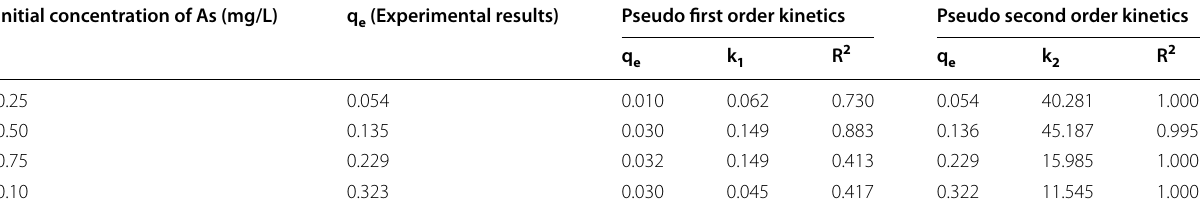
Table 1 Kinetic parameters of removal for As Initial concentration of As (mg/L) q e (Experimental results)